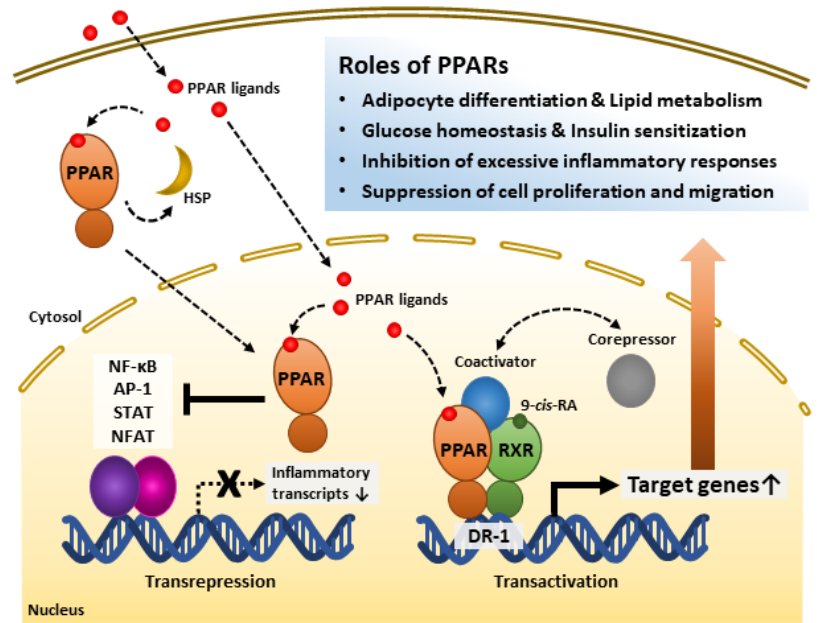
Figure 1. Roles of peroxisome proliferator-activated receptors (PPARs) and their regulatory mech- anisms. PPAR ligands bind to the PPAR ligand-binding domain and activate receptors. PPARs in- teract with heat shock protein (HSP) in the cytosol. PPARs inhibit inflammation-related gene tran- scription by interfering with transcription factors such as NF- κ B, AP-1, STAT, and NFAT. PPARs form heterodimers with Retinoid X receptor (RXR), a receptor of 9- cis -retinoic acid (9- cis -RA), and bind to direct repeat 1 (DR-1), a peroxisome-proliferator-responsive element. The PPAR-RXR heter- odimer complex and co-repressors represses target gene transcription. However, the complex with co-activators promotes target gene transcription. Through these mechanisms, PPARs play signifi- cant roles in energy metabolism, inflammatory modulation, and the cell cycle. AP-1, Activator pro- tein 1; NF- κ B, Nuclear factor kappa-light-chain-enhancer of activated B cells; NFAT, Nuclear factor of activated T cells; STAT, Signal transducer and activator of transcription. 3. PPARs and Viral Infections 3.1. PPARs and Respiratory Viral Infections Many studies have shown that PPAR γ controls viral replication and virus-associated inflammation by antagonizing inflammatory signaling pathways such as the NF- κ B and STAT pathways [74,75]. In particular, PPAR γ of alveolar macrophages critically modu- lates acute inflammation to promote recovery from respiratory viral infections, most of which are caused by influenza A virus (IAV) and respiratory syncytial virus (RSV) [76]. Several PPAR agonists have shown promise in terms of ameliorating virus-related cyto- kine storms and the damage caused by severe IAV infection [77]. Macrophage PPAR γ is essential for resolving the chronic pulmonary collagen deposition and fibrotic changes that follow influenza infection [78]. Several researchers have sought new therapeutic can- didates for IAV disease. A recent screening of traditional Chinese medicines showed that emodin and analogs thereof evidenced excellent anti-IAV activities mediated by activa- tion of the PPAR α / γ and adenosine monophosphate (AMP)-activated protein kinase (AMPK) pathways [79]. High-throughput screening of natural compounds and/or syn- thetic drugs/agents will yield new therapeutics against respiratory viral infections based on drug interactions with PPAR pathways. A link has been suggested between severe acute respiratory syndrome coronavirus 2 (SARS-CoV-2) virus infection and PPAR α activity in the context of lipid uptake,